Question: In a single sentence, describe what this figure presents.
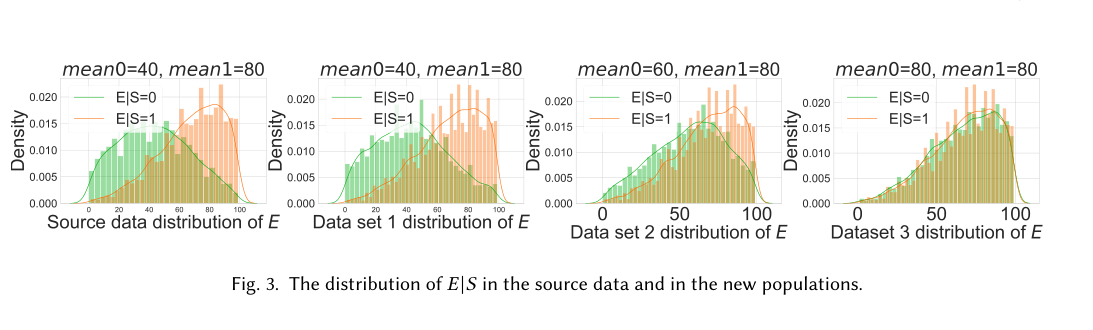
Answer: shows the Wasserstein distances between the true distributions and the estimated ones. As we can see, BaBE